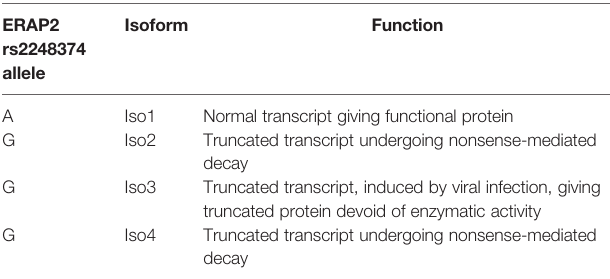
TABLE 1 | ERAP2 isoforms (45,